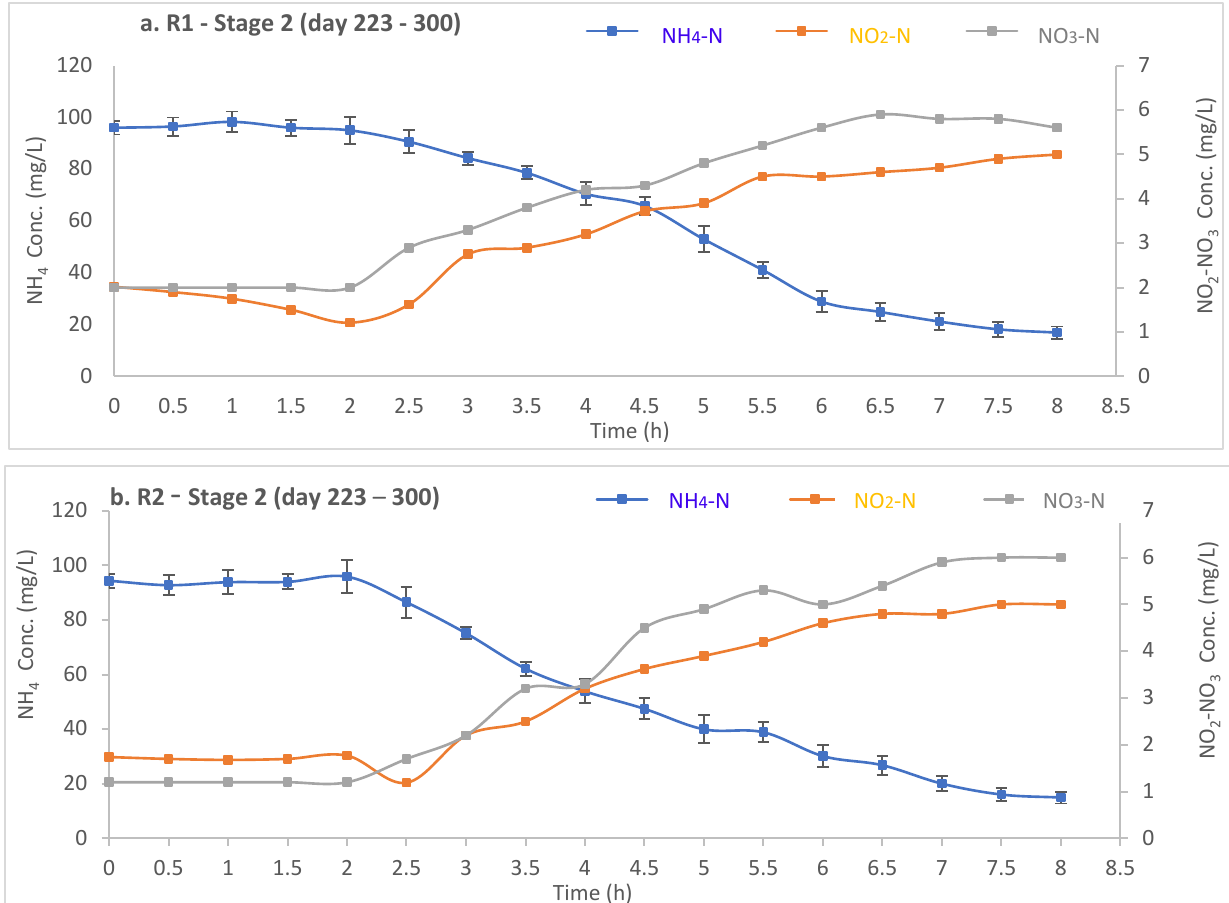
Figure 3. EPS measurements (protein + carbohydrate) over the entire operational period (360 days) of ( a ) R1 and ( b ) R2.